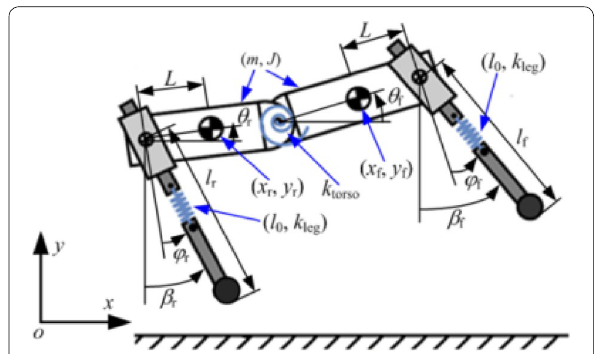
Figure 1 Simplified model of the cheetah